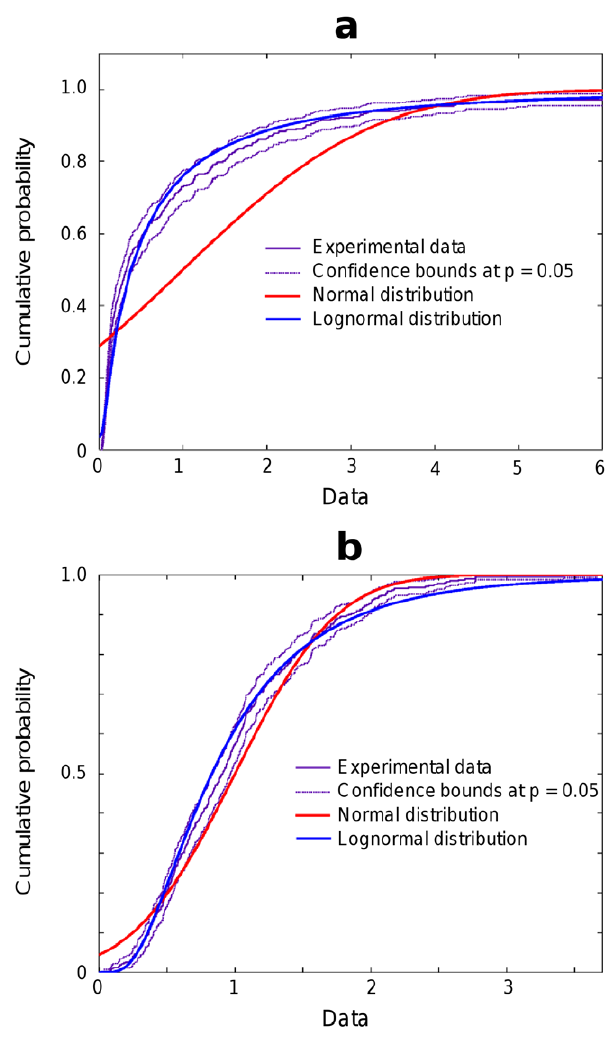
Figure 3. Cumulative distribution functions. ( a ) Plot of empirical cumulative distribution function (experimental data) for time interval 2, channel 1 ( s 2 ~ 1 : 44 ) together with theoretical cumulative distribution function plots for normal and lognormal distributions. ( b ) Plot of empirical cumulative distribution function for time interval 11, channel 3 ( s 2 ~ 0 : 21 ). In both cases the confidence interval for experimental data is computed at p-value of 0.05.